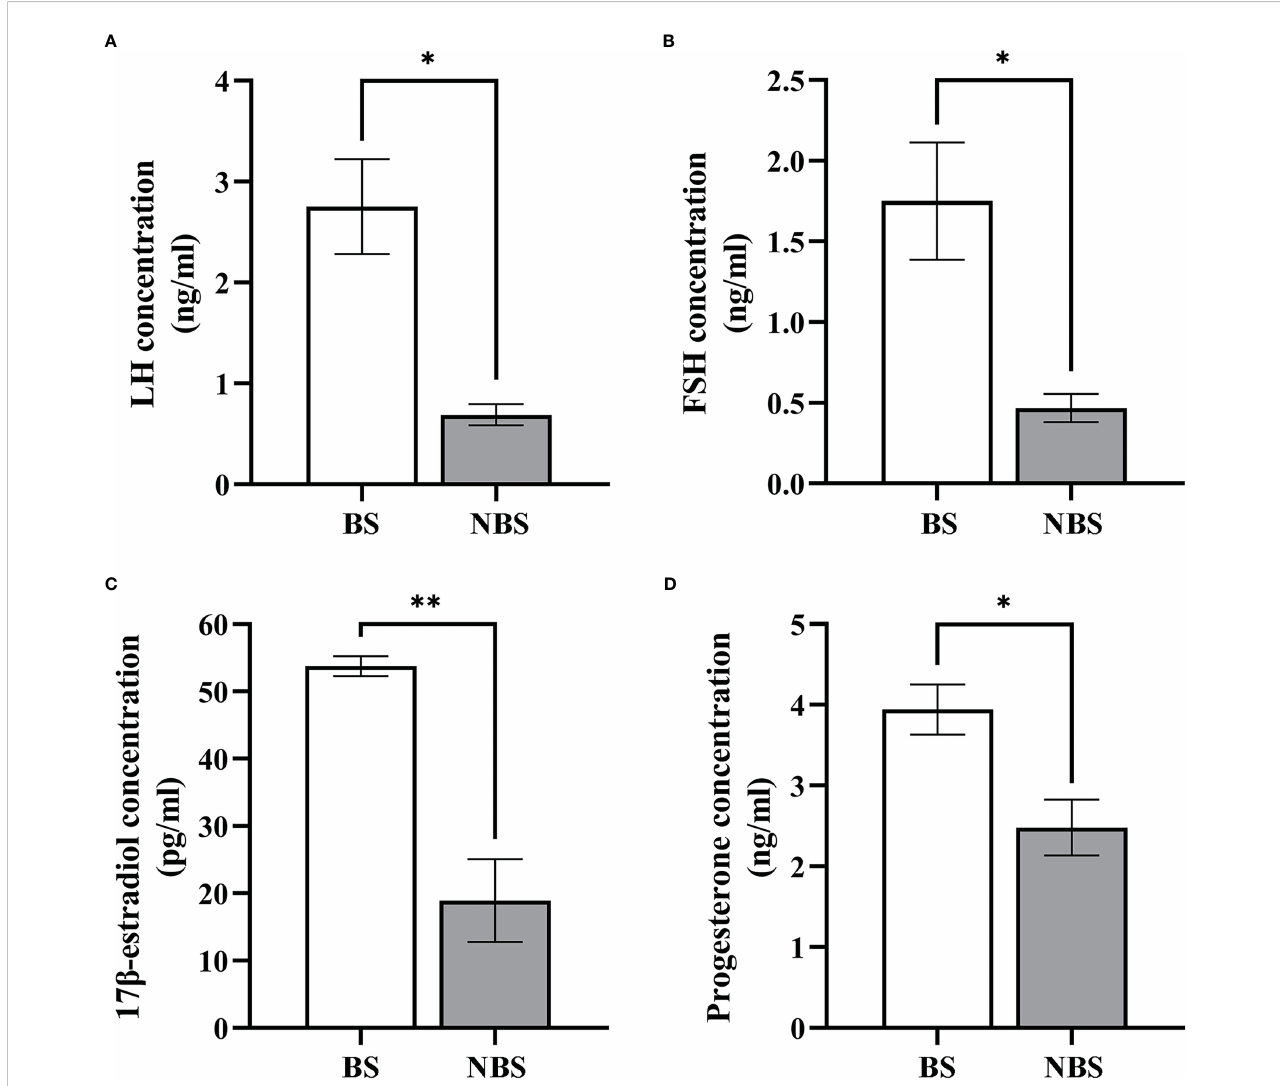
FIGURE 8 Seasonal change of the concentration of LH, FSH, estradiol-17 b , and progesterone. Serum LH (A) , FSH (B) , 17 b -estradiol (C) , and progesterone (D) levels in the muskrats during the breeding season (BS) and non-breeding season (NBS). *Statistically signi fi cant values (* P < 0.05, ** P <